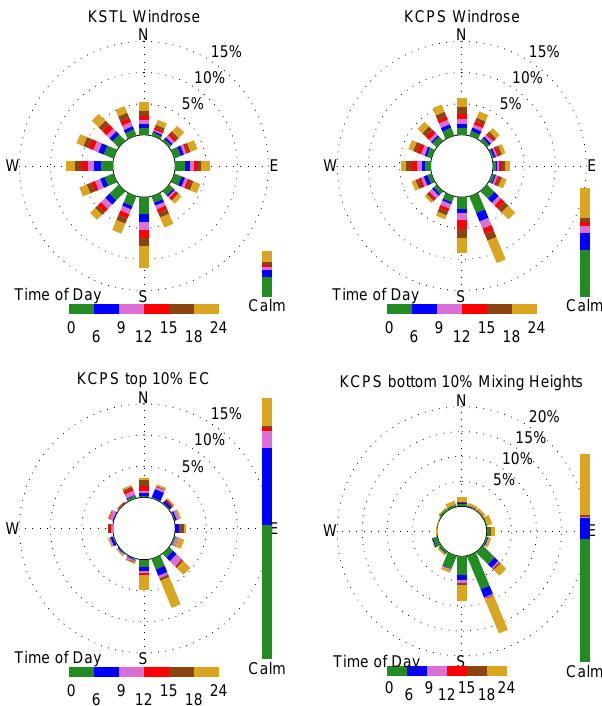
Figure 5. Top: wind roses for Lambert–St. Louis international airport (KSTL) and Downtown St. Louis airport (KCPS). Bottom: wind roses for hours in the top 10% of EC concentrations at the supersite using KCPS data, and bottom 10% of WRF mixing layer height. Color indicates time of day.